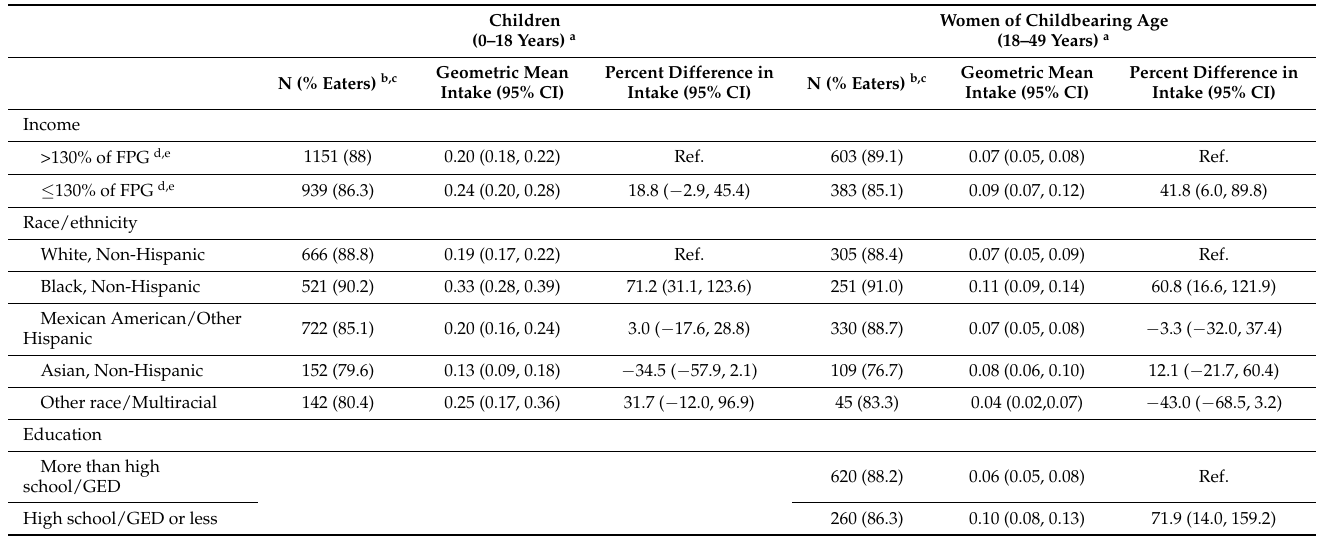
Table 4. Associations between race/ethnicity and measures of socioeconomic status and two-day average total estimated artificial food coloring intake (mg/kg/day) in children and women of childbearing age who consumed at least one food containing an